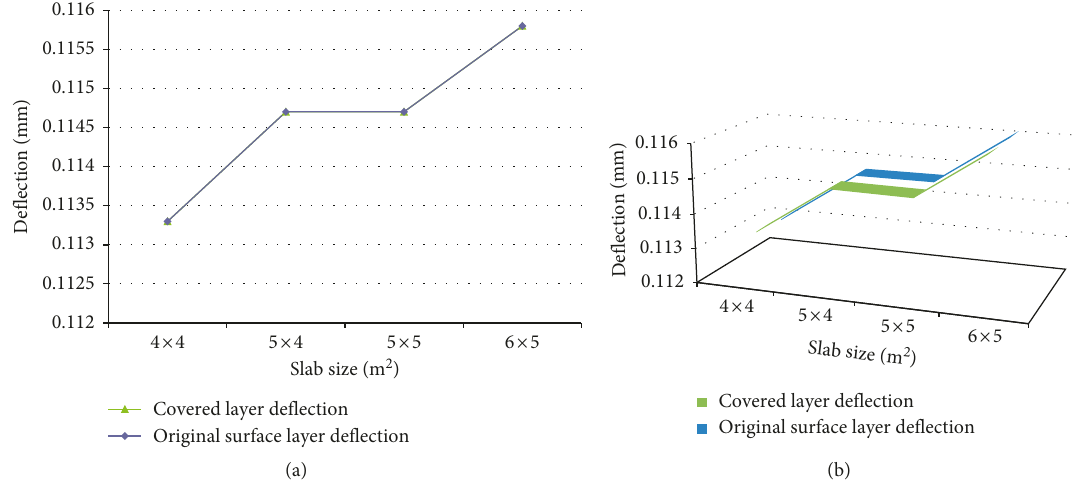
Figure 24: Variation of maximum deflection with slab